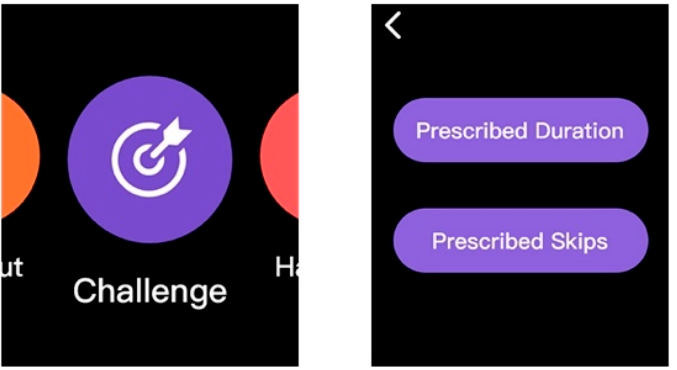
Figure 15. Optimized smartwatch